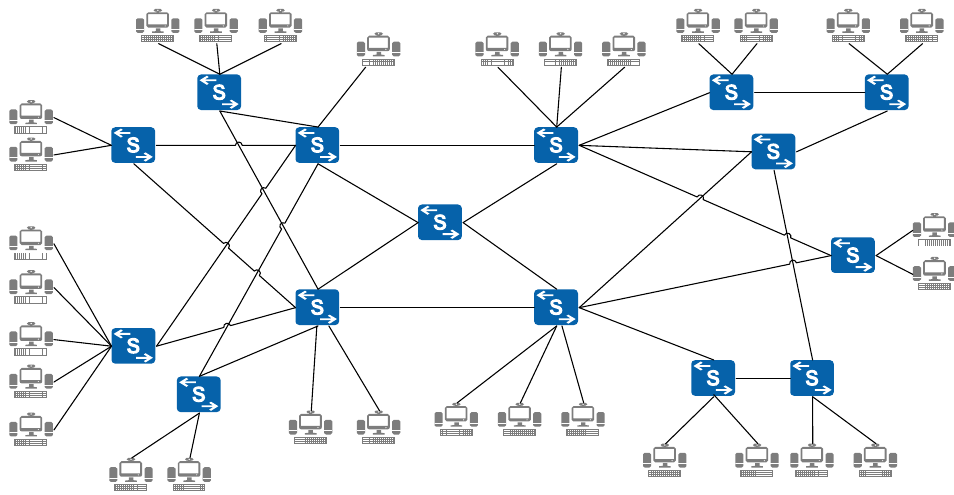
Figure 7. Network topology of the Orion CEV.